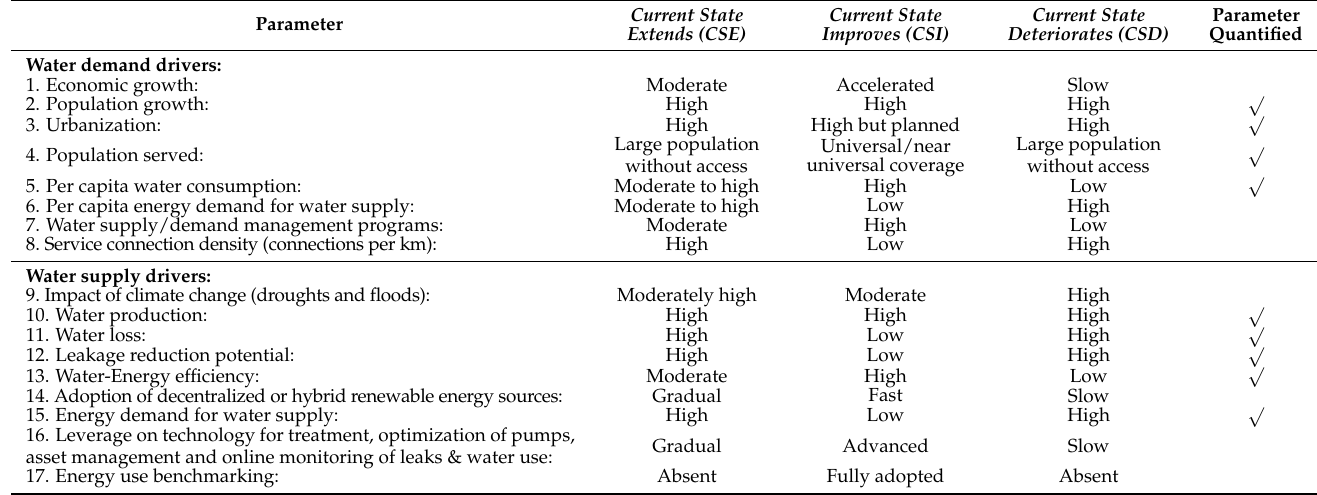
Table 1. Summary of the key narratives for three plausible scenarios ( Current State Extends , Current State Improves and Current State Deteriorates ) that were developed and applied for the current study. Parameter Current State Extends (CSE) Current State Improves (CSI) Current State Deteriorates (CSD) Parameter